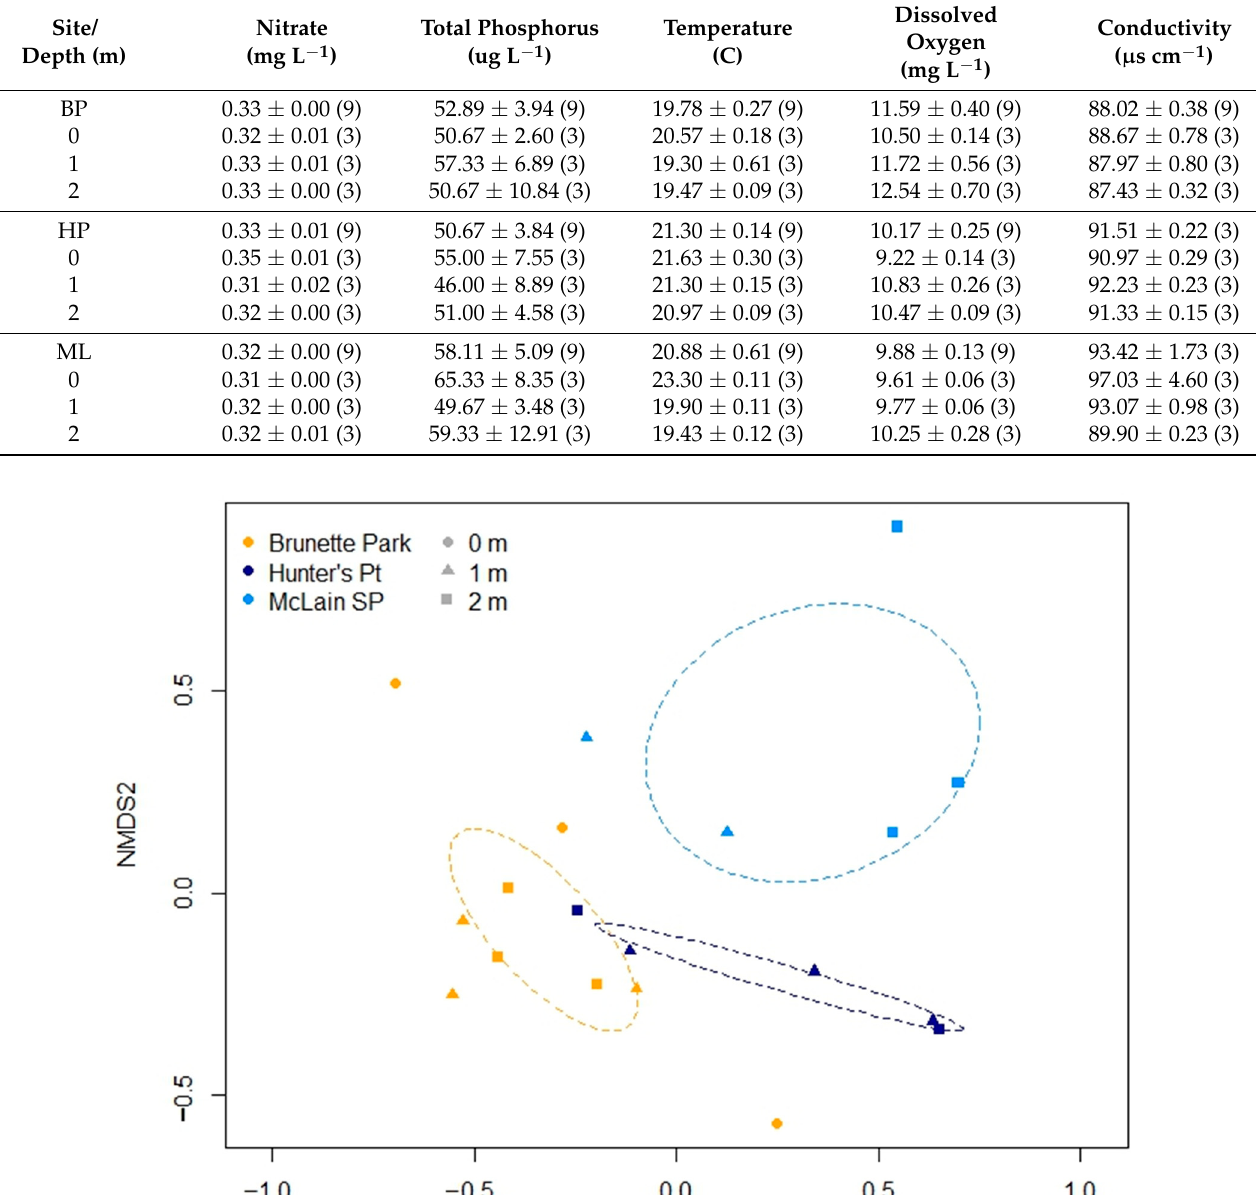
Table 2. Mean nitrate, total phosphorus, temperature, dissolved oxygen, and conductivity with standard error and number of